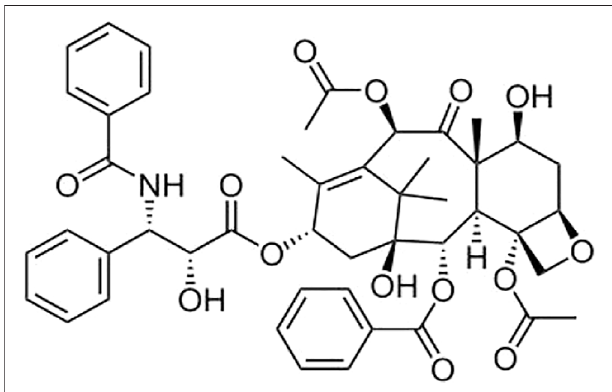
FIGURE 1 | Molecular structure of PAC.